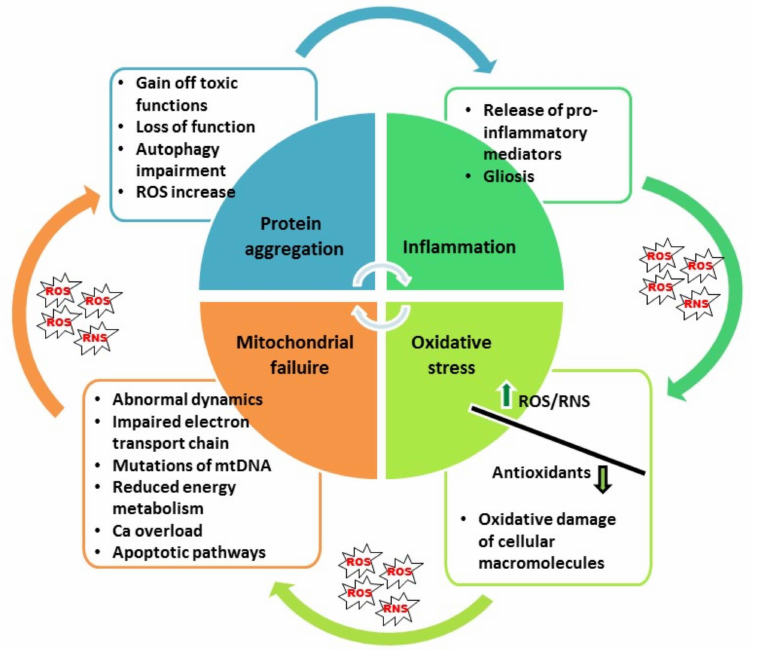
Figure 1. Vicious cycle of oxidative stress, mitochondrial failure, protein aggregation and inflamma- tion in neurodegenerative diseases. 3. Neuroinflammation in Neurodegenerative Diseases: The Role of NF- κ B